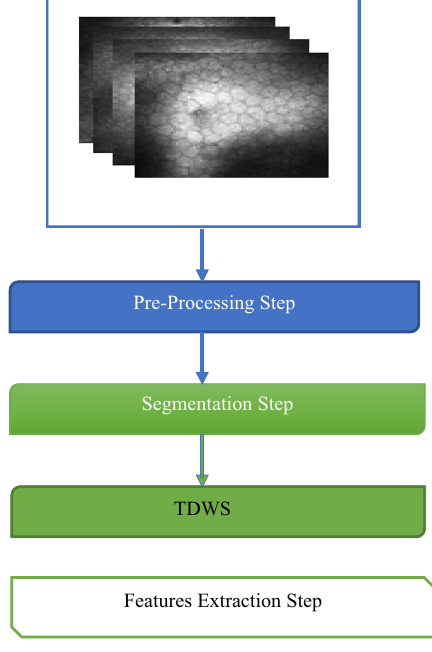
Figure 15: Medical feature